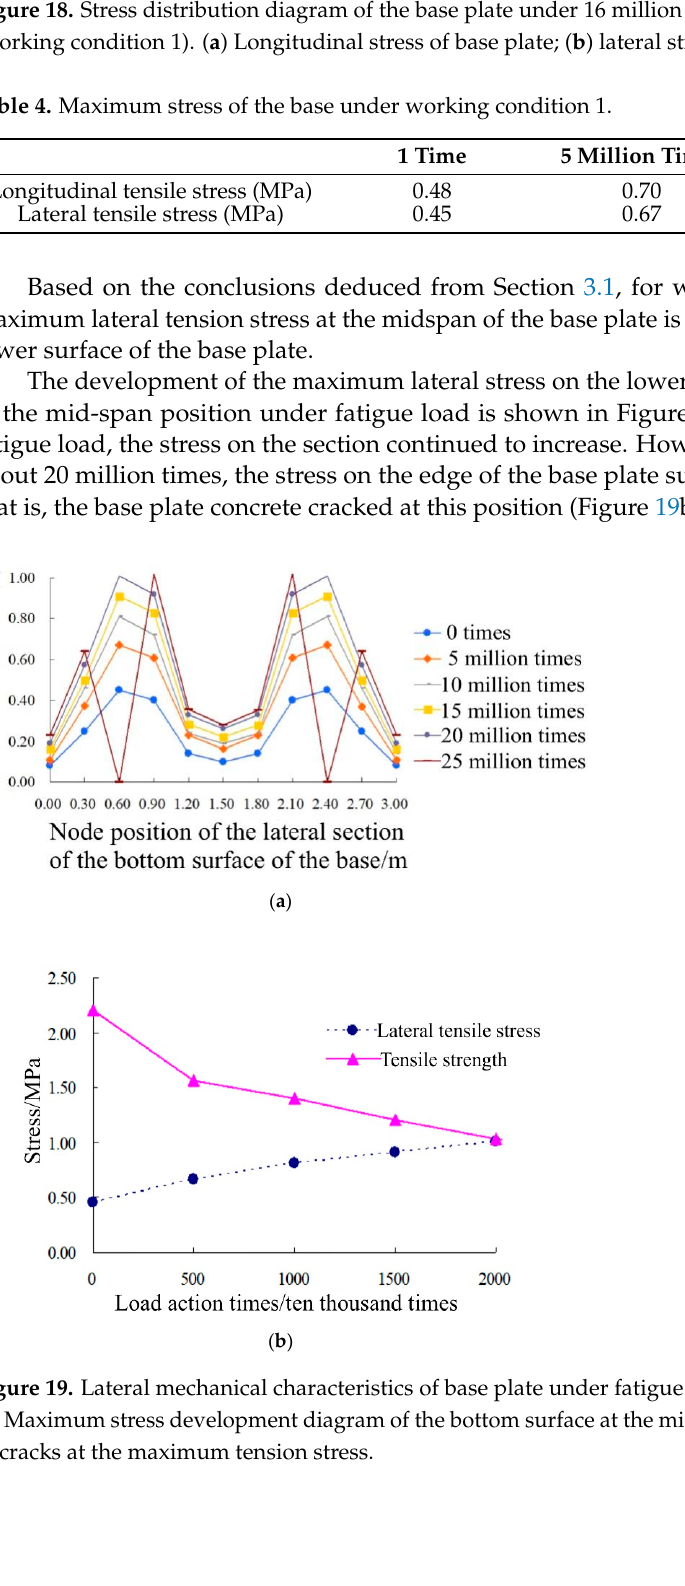
Figure 18. Stress distribution diagram of the base plate under 16 million applications of fatigue load (working condition 1). ( a ) Longitudinal stress of base plate; ( b ) lateral stress of base plate.